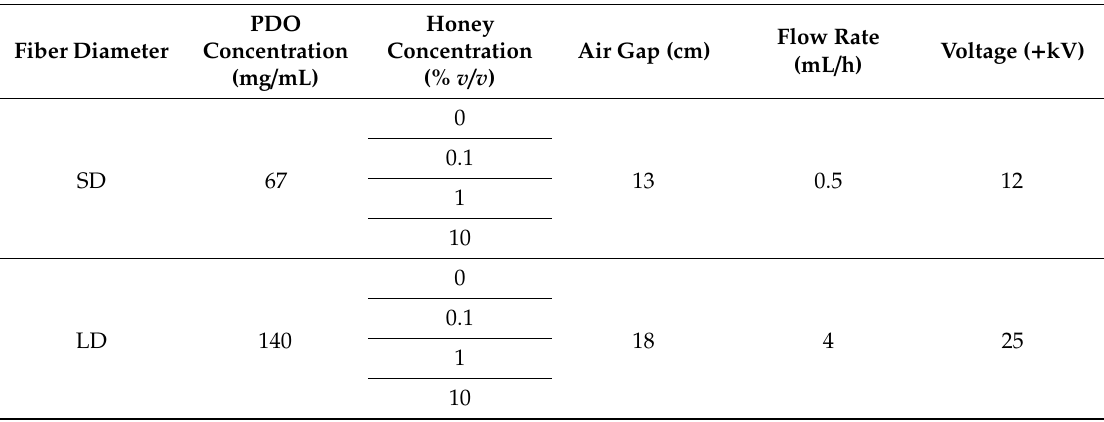
Table 2. Electrospinning parameters for each template type at high humidity conditions. Due to fluctuating humidity in the laboratory throughout this study, two sets of parameters had to be used to maintain consistent fiber diameters for each template